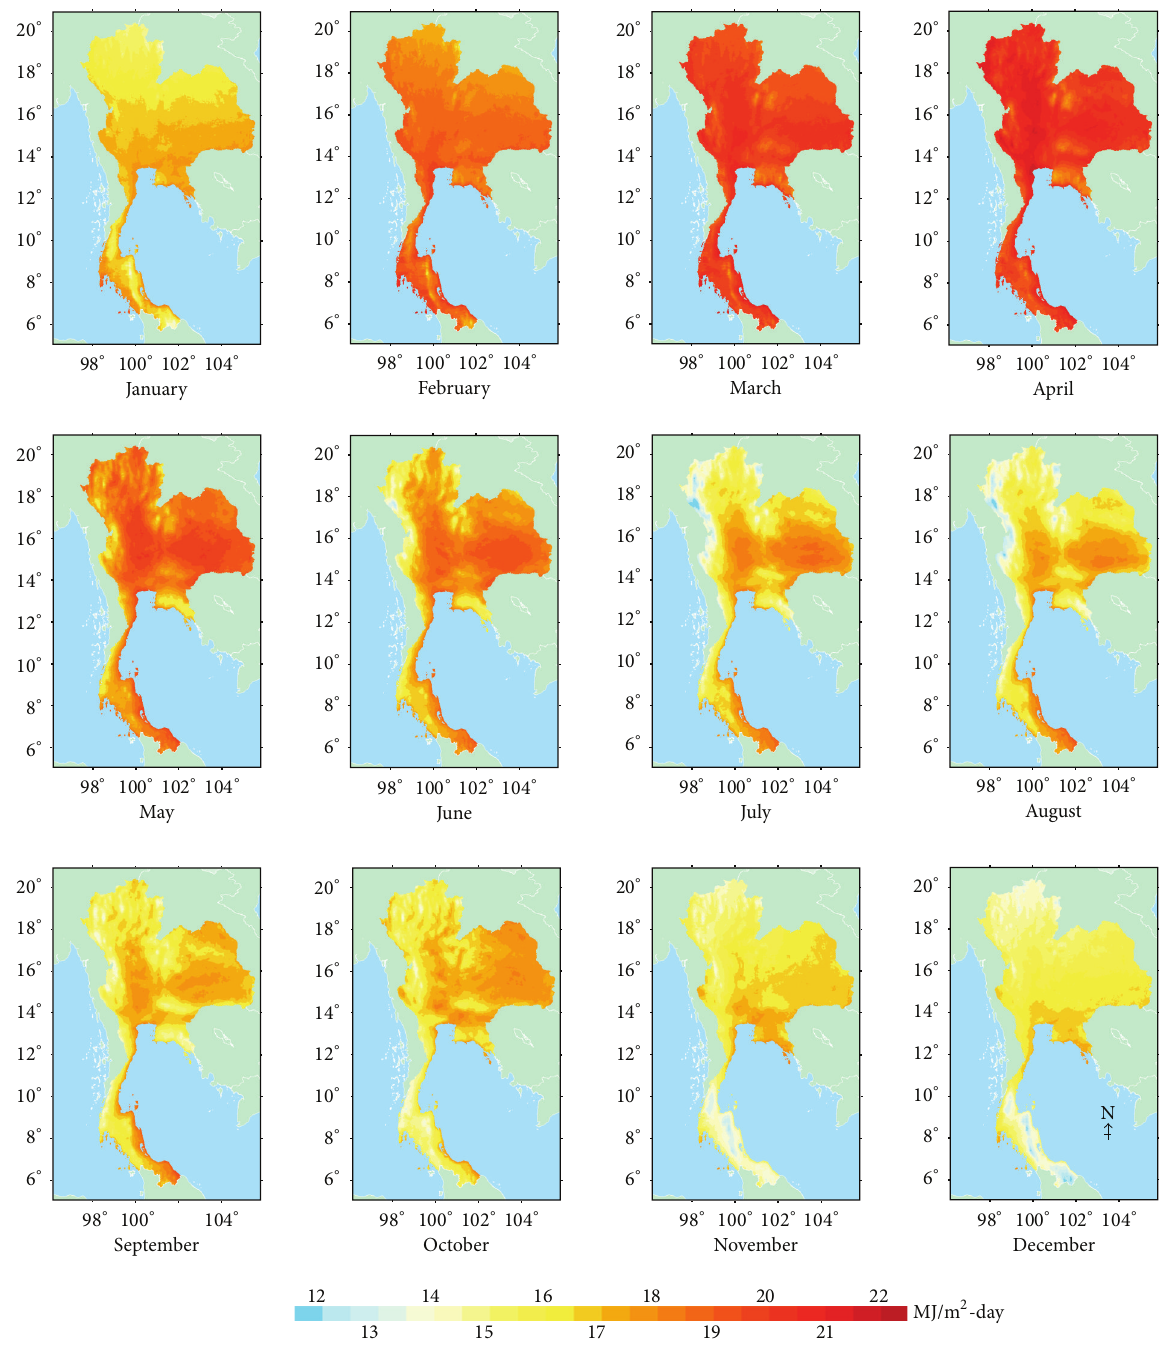
Figure 4: Monthly average of daily global radiation over